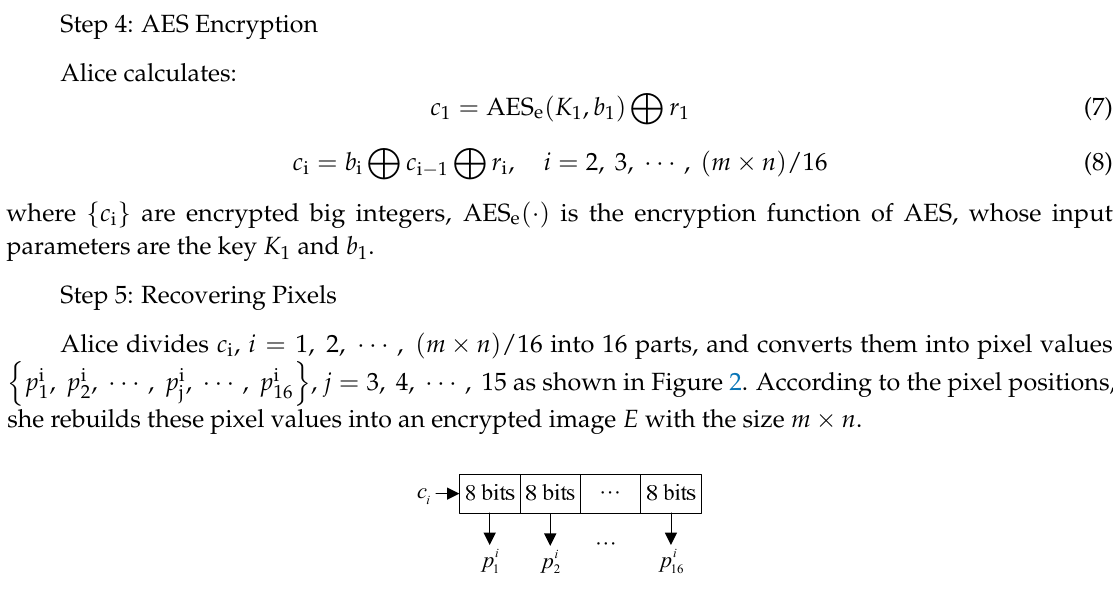
Figure 2. Converting an encrypted big integer into pixel values.